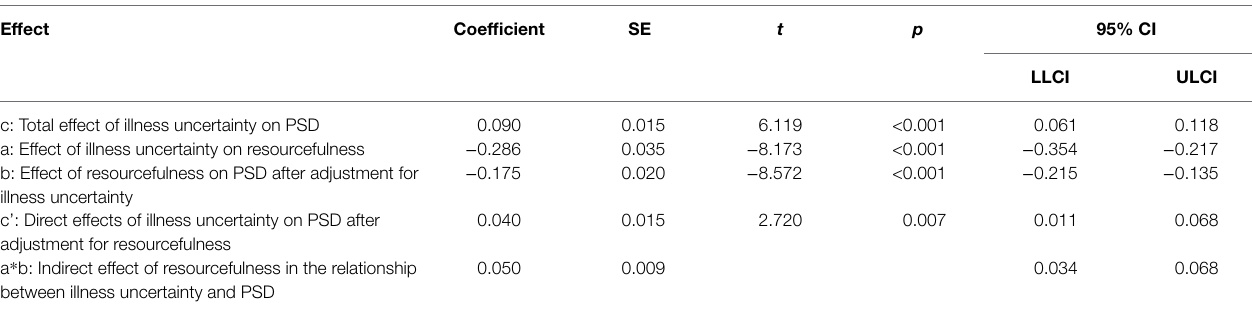
TABLE 5 | Mediation of resourcefulness between illness uncertainty and PSD ( n = 355).